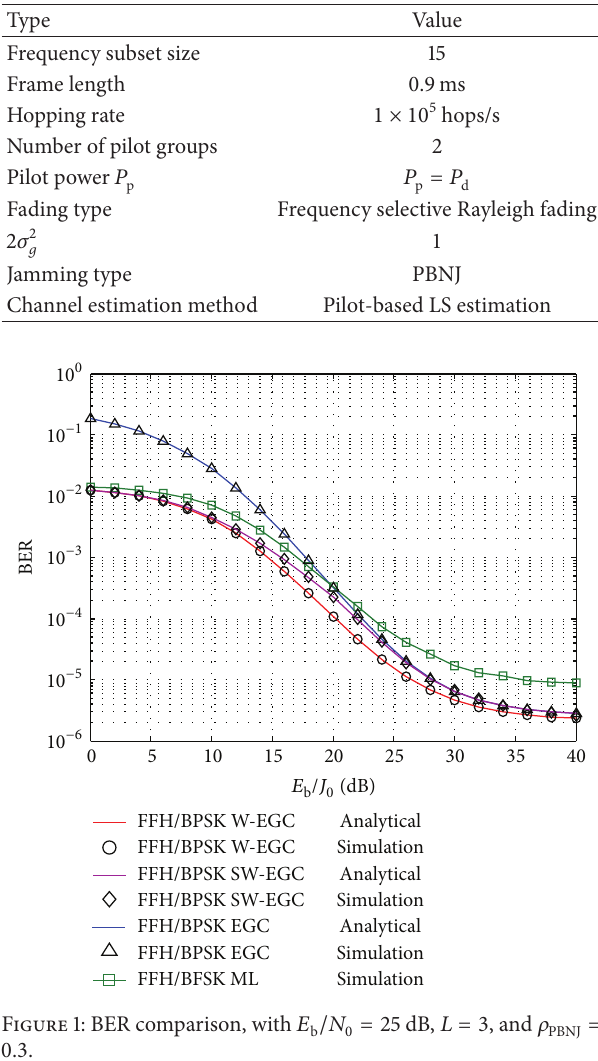
Figure 1: BER comparison, with 𝐸 0.3